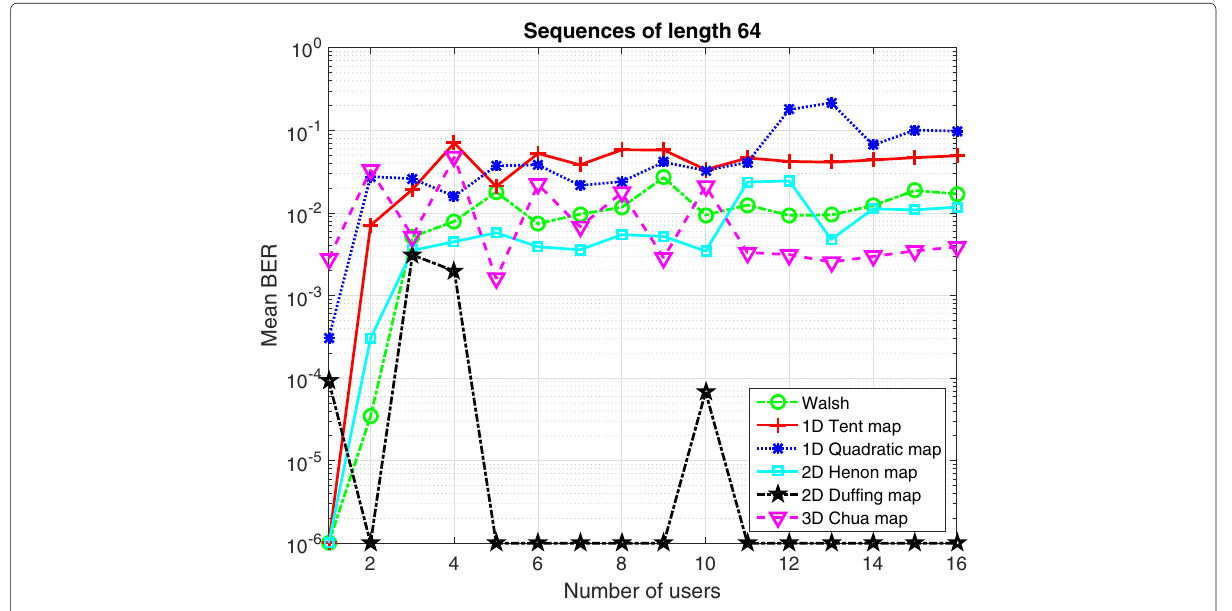
in the main peak. Mean Pearson coefficient shows the cross-correlation or linear dependence of all sequences in a set. Codes that are used in spread spectrum systems need to have a large autocorrelation and low cross- correlation value. It can be seen from Tables 1, 2,